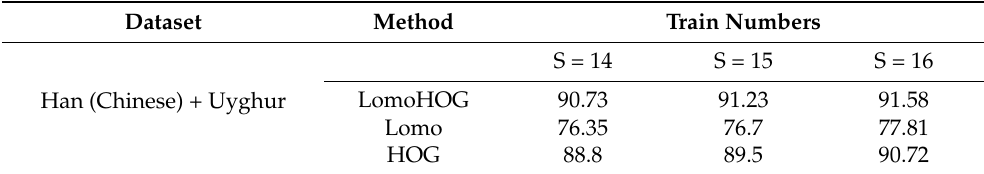
Table 8. Mixed multilanguage signature recognition results were based on different features.